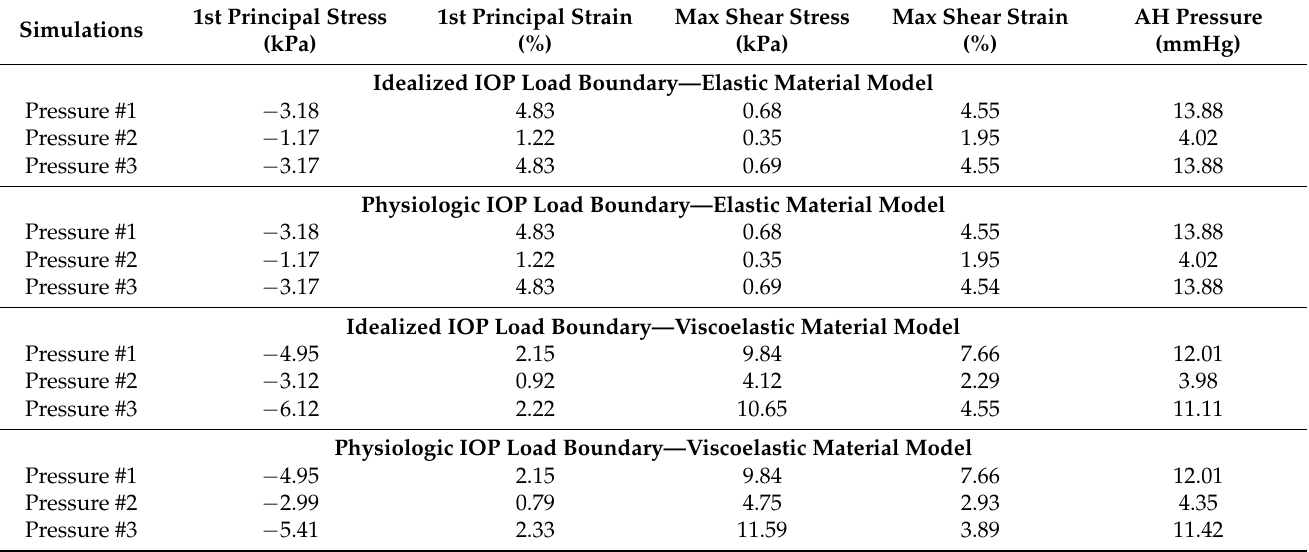
Table 1. Volumetric average stresses and strains in the TM/JCT/SC complex and volumetric average pressure in the aqueous